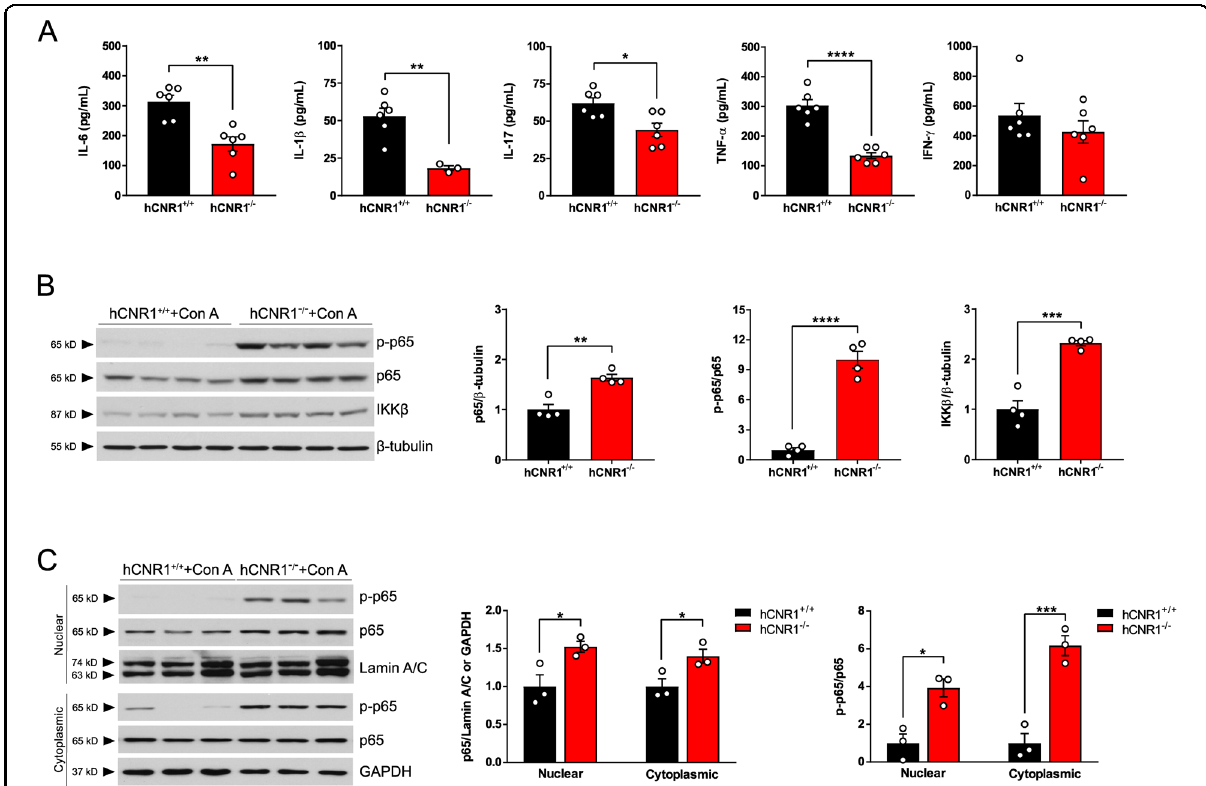
Fig. 3 Con A-induced in fl ammation was suppressed in hCNR1 − / − mice. hCNR1 + / + and hCNR1 − / − mice were injected with Con A (5 mg/kg) for 12 h ( n = 6). A Blood samples were collected post-Con A injection (5 mg/kg) after 12 h period ( n = 3 – 6) and measured proin fl ammatory cytokines, IL- 6, IL-1 β , IL-17, TNF- α , and IFN- γ . B Protein extracts from liver homogenates were immunoblotted and detected by autoradiographic signals. The bands were subjected to densitometric quanti fi cations for protein expression levels of total p65, phospho-p65 (p-p65), and IKK β ( n = 4). C Total p65 and p-p65 nuclear and cytoplasmic protein amounts in the liver lysates. Nuclear and cytoplasmic fractions were normalized to lamin A/C and GAPDH, respectively. Results were expressed as mean ± S.E.M. (* p ≤ 0.05, ** p ≤ 0.01, *** p ≤ 0.001, **** p ≤ 0.0001 compared to hCNR1 + / +